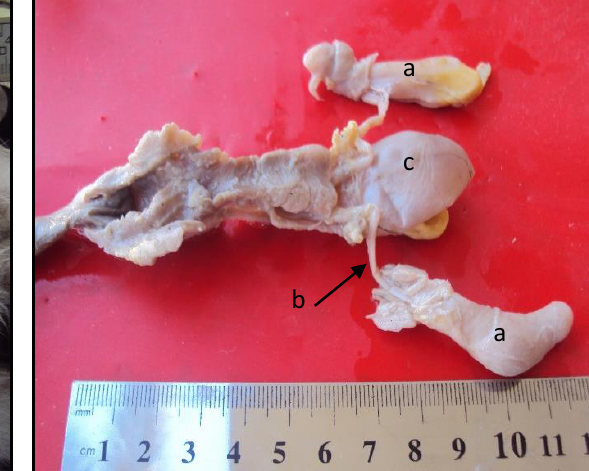
Figure, 9: Shows the shape, size and topographic position of testis in situ of the rabbit at 120- days age a-testis b- kidney c-ligament of the tail of epididymis d- part of inguinal canal e-urinary bladder f- rectum.